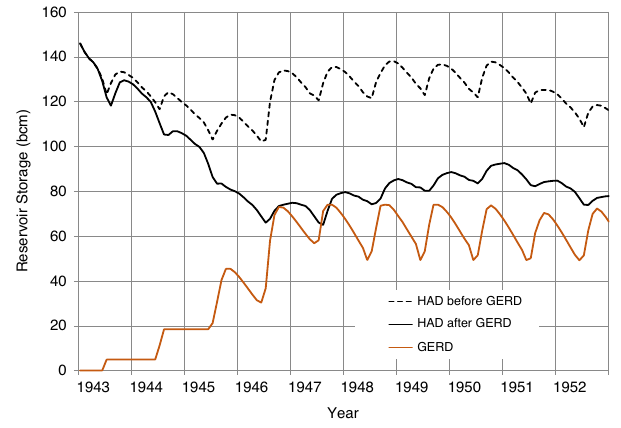
Fig. 4 GERD fi lling effects under a historically near-average 10-year sequence. Storage volumes for the GERD and HAD are